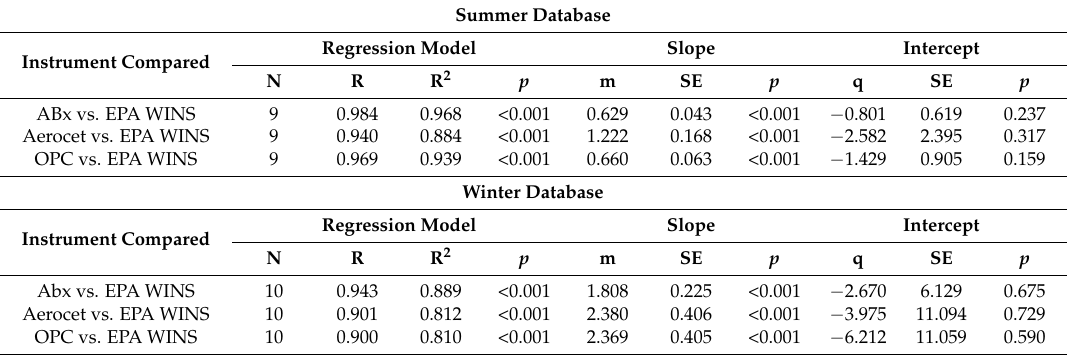
Table 10. Regression parameters between direct-reading instruments and EPA WINS (8-h averaged data). Regression parameters were calculated and reported for the summer and winter datasets.